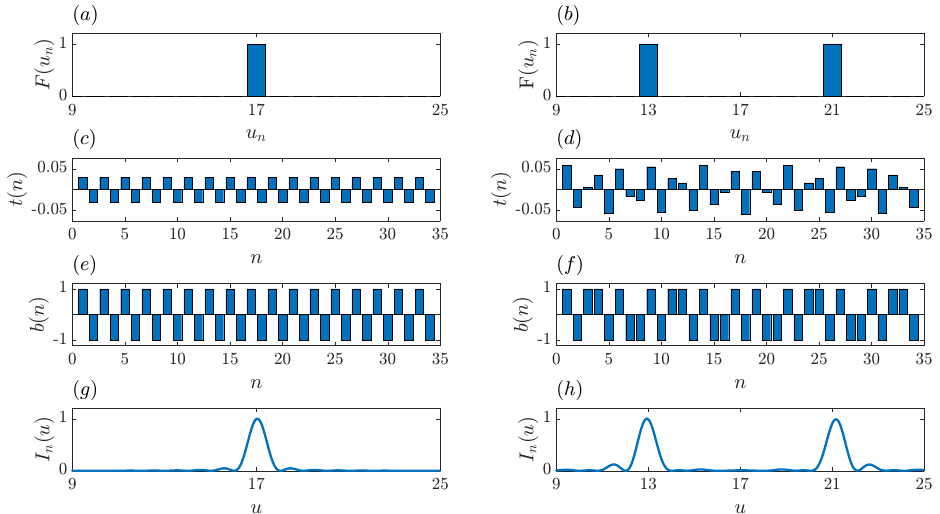
Figure 3. Generation of the ZP binary sequence for a monofocal focusing profile ( a , c , e , g ) and a bifocal focusing profile ( b , d , f , h ). Target focusing profiles: ( a , b ). Transmittance sequences: ( c , d ). Binary sequences: ( e , f ). Normalized focusing profiles, computed with the Rayleigh-Sommerfeld diffraction integral, as a function of u : ( g , h